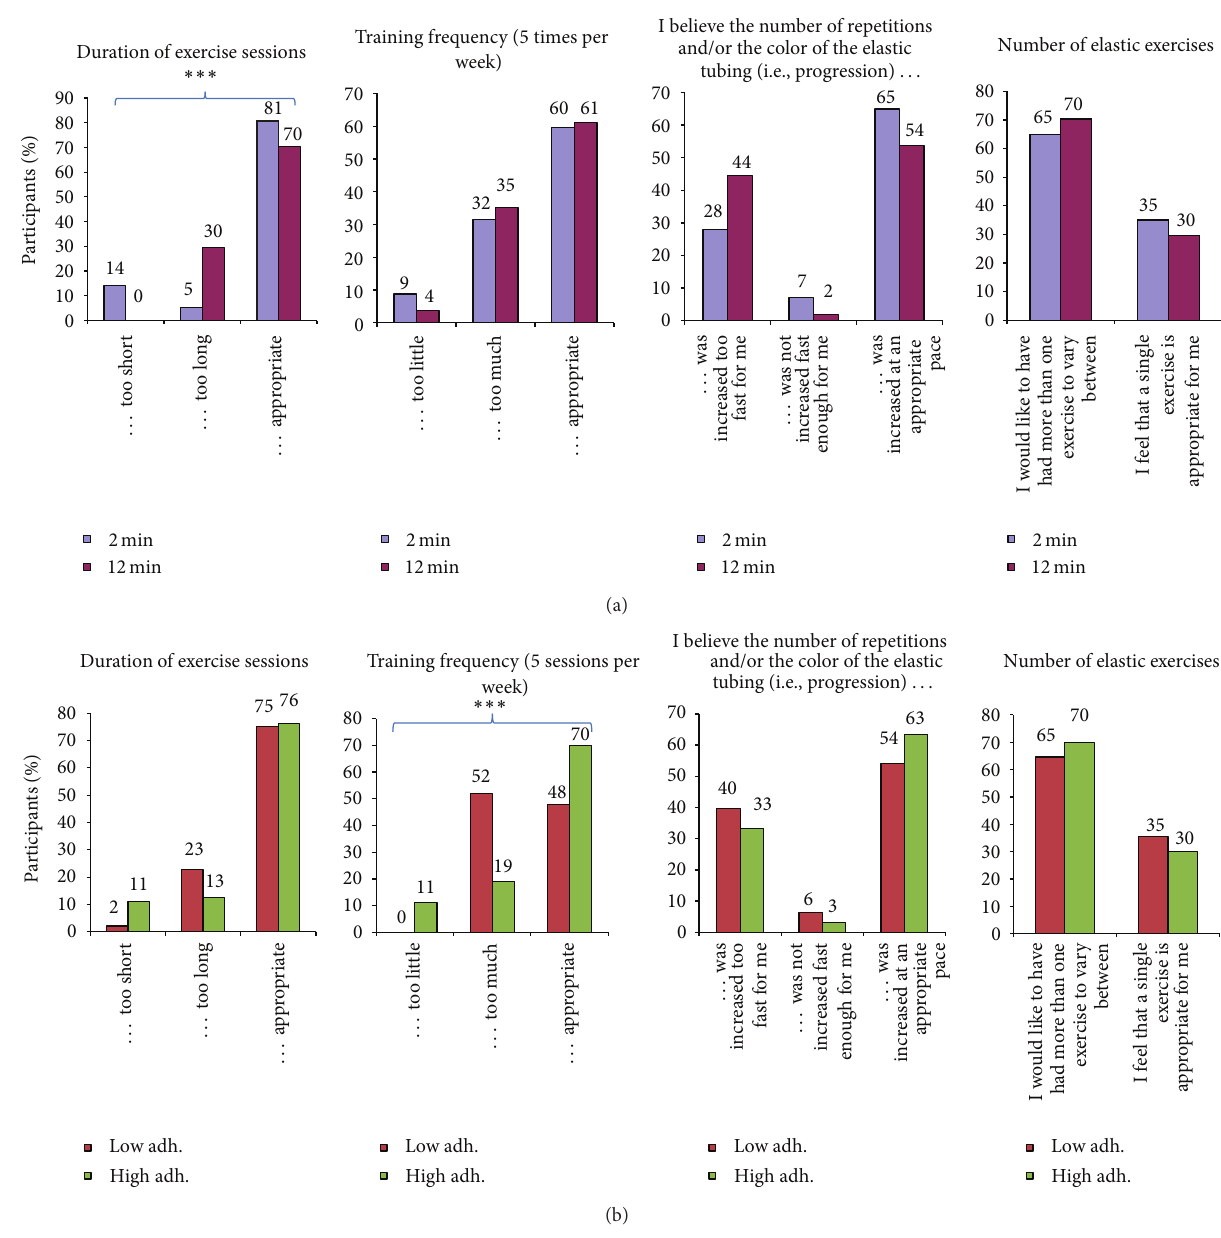
Figure 2: (a) Follow-up questionnaire (satisfaction, barriers, and facilitators). Participant feedback on the characteristics of the training program, that is, duration of exercise sessions (1st panel), training frequency (2nd panel), progression (3rd panel), and number of exercises (4th panel) in the 2 and 12 min groups. ∗∗∗ Significant difference (Fisher’s exact test, 𝑃 < 0.001 ). (b) Follow-up questionnaire (satisfaction, barriers, and facilitators). Participant feedback on the characteristics of the training program, that is, duration of exercise sessions (1st panel), training frequency (2nd panel), progression (3rd panel), and number of exercises (4th panel) among those with low and high adherence. ∗∗∗ Significant difference (Fisher’s exact test, 𝑃 < 0.001